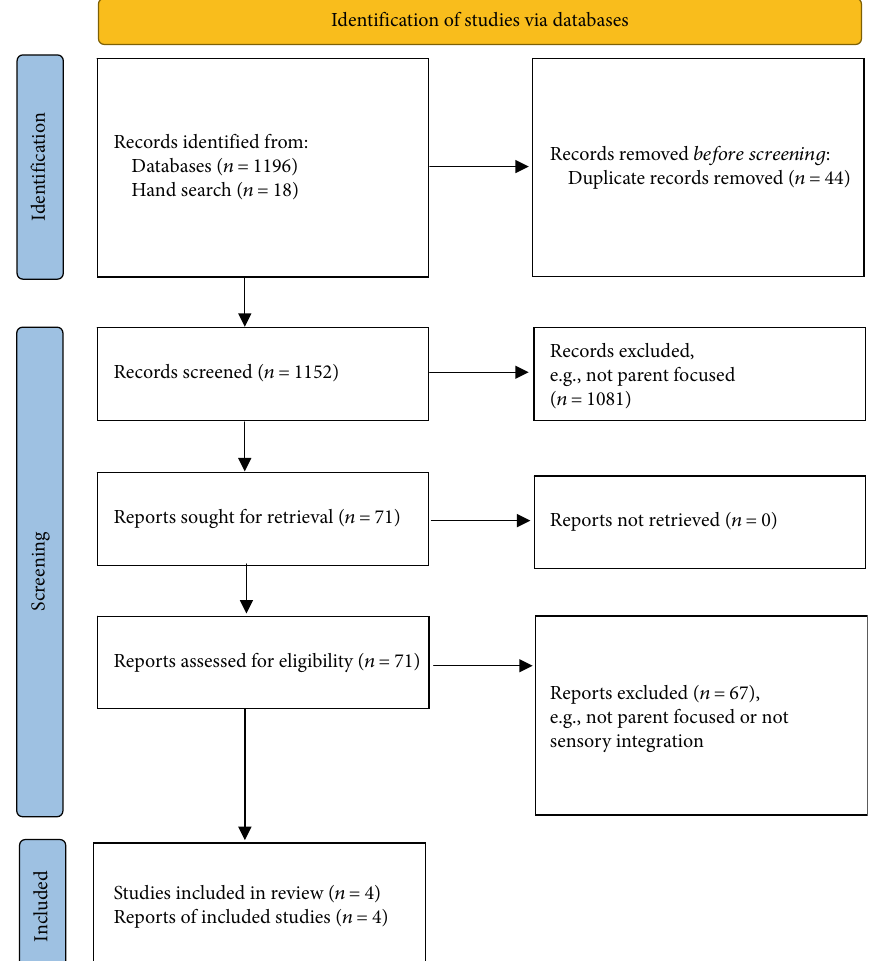
Figure 1: PRISMA 2020 fl ow diagram. Systematic review of interventions for parents of children with sensory processing and integration di ffi